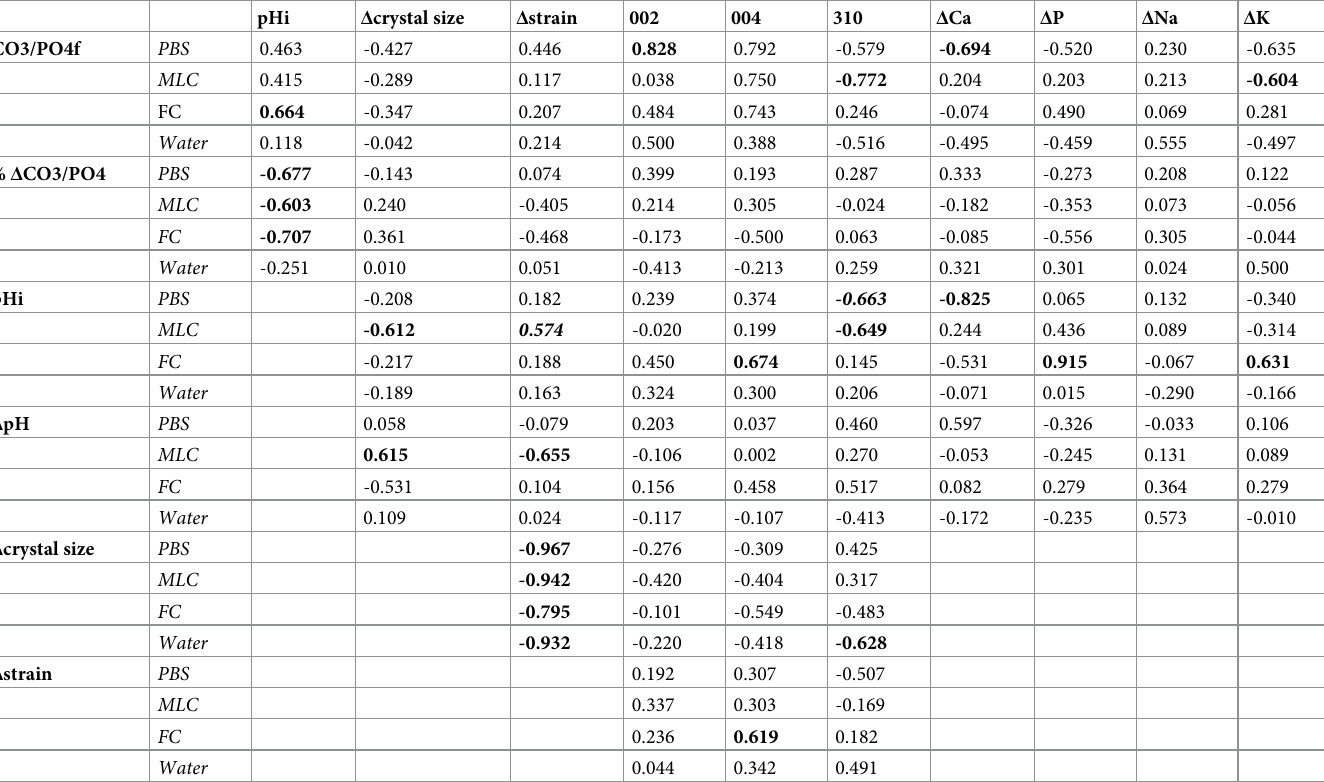
Table 1. Correlation between all solution and powder conditions and